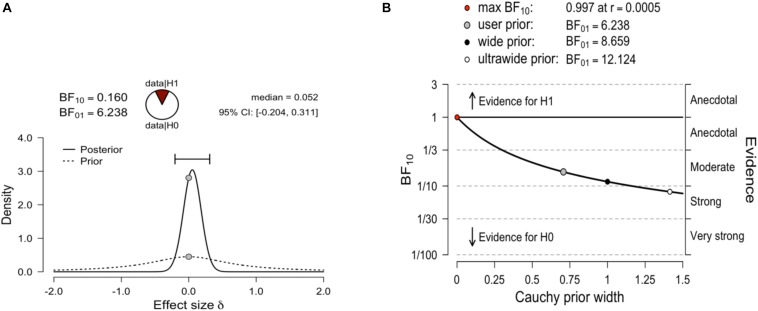
(A) Bayesian independent samples t-test for the effect size δ. The probability wheel on top visualizes the evidence that the data provide for the null hypothesis (H0: effect sizes are equal) and the alternative hypothesis (auburn, H1: effect sizes are different). The median and the 95% central credible interval of the posterior distribution are shown in the top right corner. (B) The Bayes factor robustness plot. The plot indicates the Bayes factor BF01 (in favor of the null hypothesis) for the default prior (r = 0.707), a wide prior (r = 1), and an ultrawide prior (r = 1.414).